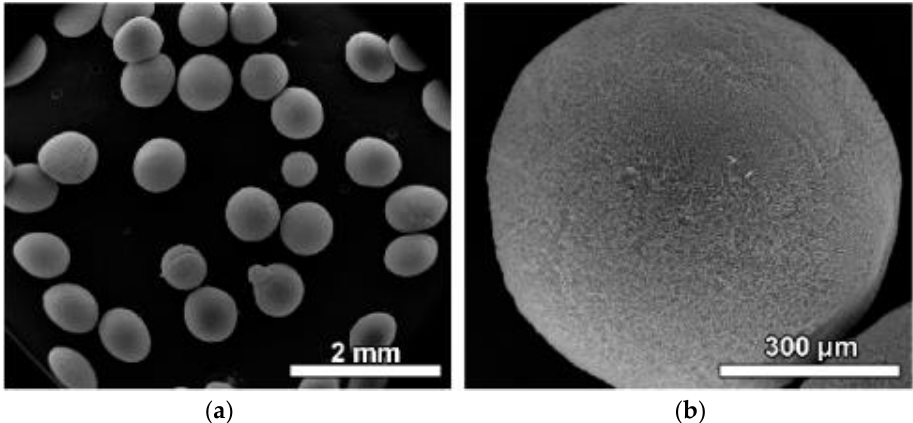
Figure 6. SEM images of chitosan microspheres at ( a ) low and ( b ) high magnifications. Figure adapted from Ref. [121].